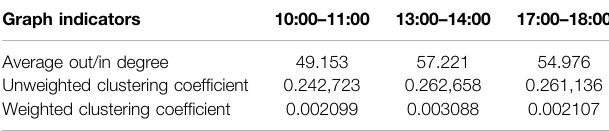
TABLE 3 | Mean values of graph indicators in different time intervals.